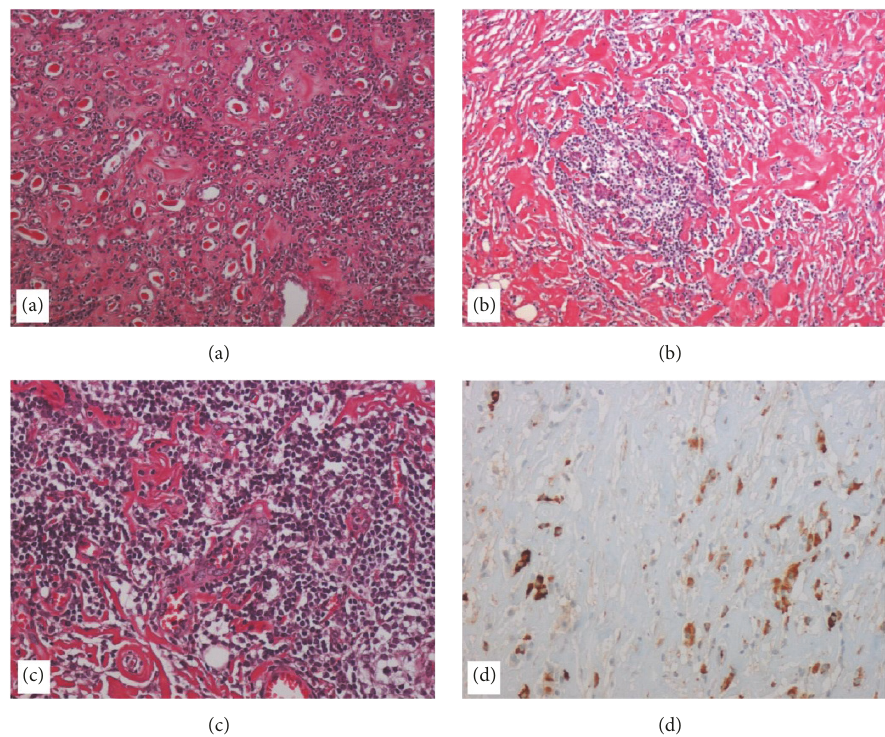
Figure3:Histologicalfindings.(a)Histologicalsectionofkidneyparenchymashowingachronicpyelonephritischaracterizedbythepresence of interstitial fibrosis, inflammatory infiltrate of lymphocytes and plasma cells, and atrophy and dilatation of tubules that contain pink casts (hematoxylin-eosin (H-E), 10x). (b) The fibroadipose tissue of the kidney capsule typically shows the histological findings of IgG4-related disease, characterized by an irregularly whorled pattern of fibrosis (storiform fibrosis) associated with inflammatory infiltrate (H-E, 10x). (c) A vein obliterated by a transmural inflammatory cell infiltration (obliterative phlebitis) (H-E, 20x). (d) Immunostaining with anti-IgG4 antibody shows the presence of numerous positive cells ( ×